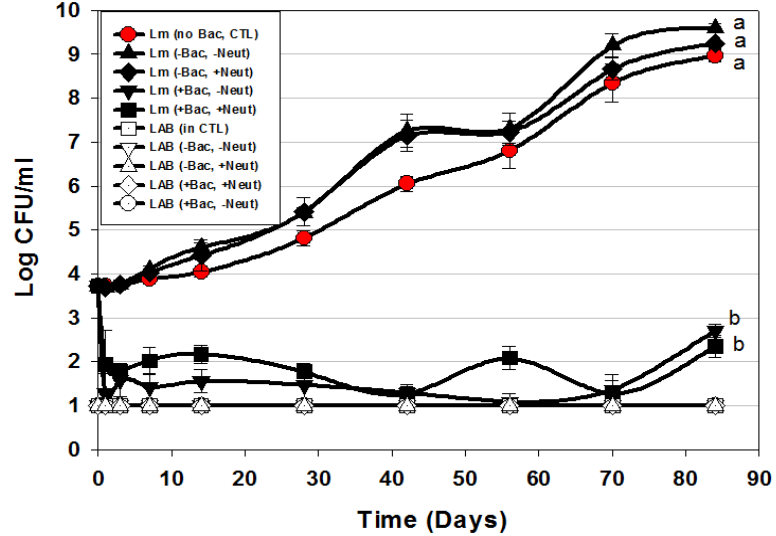
Figure 6. Hotdog challenge study vs. L. monocytogenes 39-2 with surface-applied bacteriocin extracts (+Bac) comprising mixed MOAs (curvaticin FS47 and Beef3, pediocin Bac3, and lacticin FLS1) and neutralized (+Neut) vs. non-neutalized (-Neut) culture extracts (Trial #5). Lb. delbueckii 4797 was used for bacteriocin-negative (-Bac) CFS extracts that were also used both neutralized (+Neut) and non-neutralized (-Neut). All sample treatments were performed in triplicate replication; data points represent the mean and error bars represent the standard deviation from the mean. Treatments with different letters are significantly different (repeated measures, p < 0.05); those sharing the same letter are not significantly different, p > 0.05).